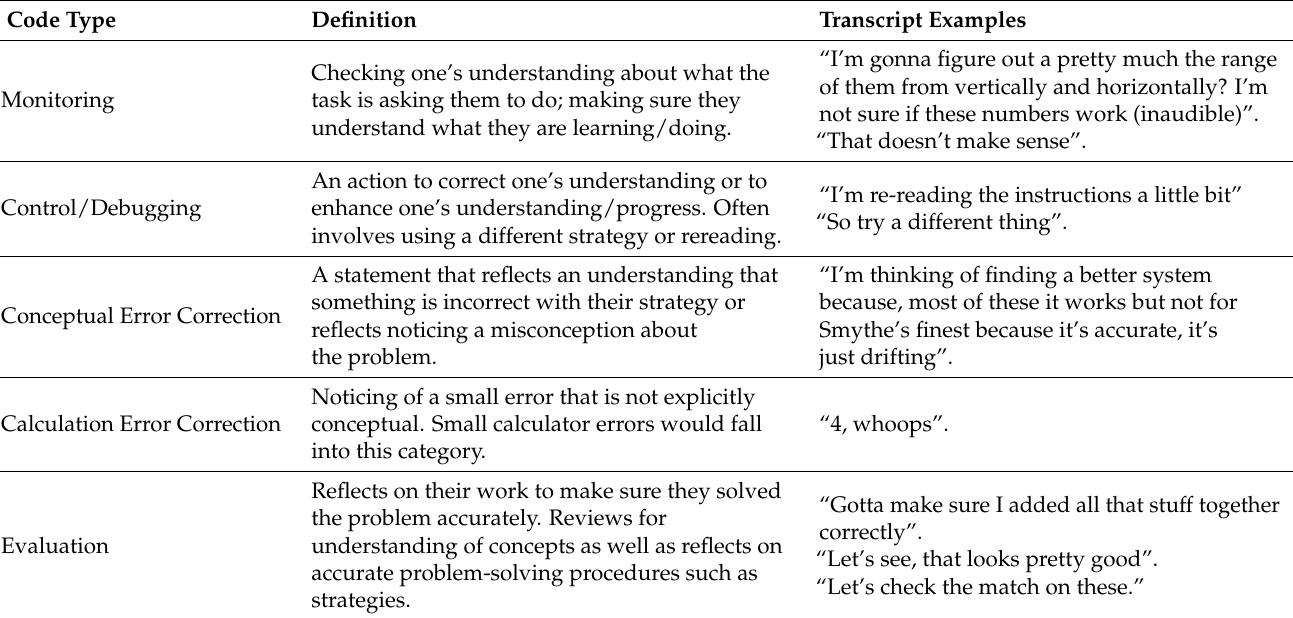
Table 2. Verbal coding